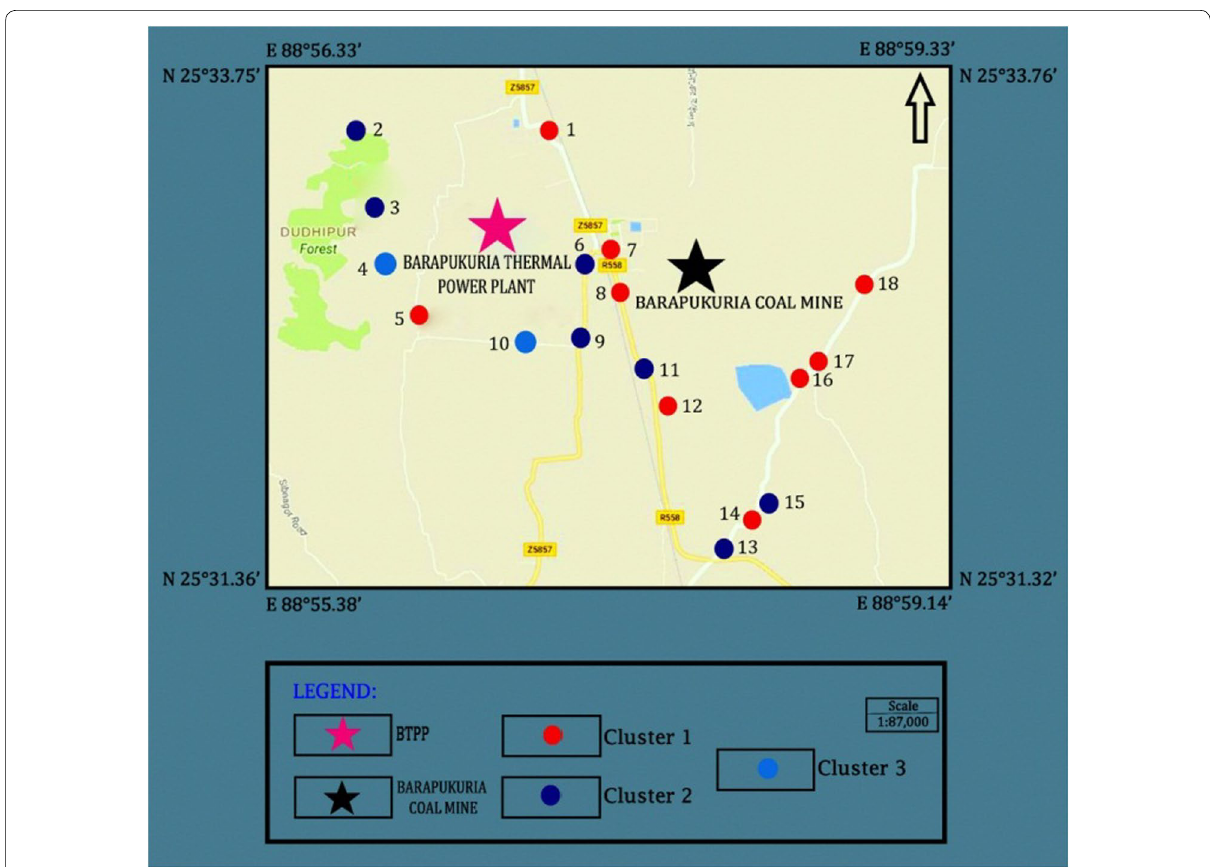
Fig. 6 The status of the quality of soil around the mining